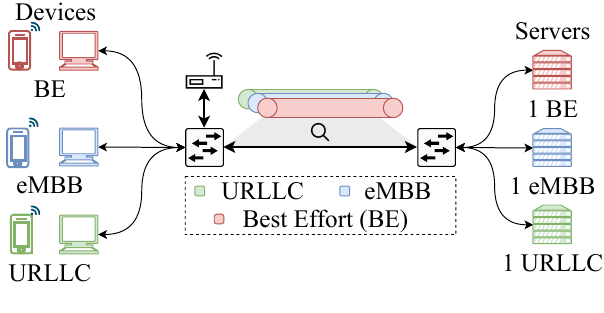
Figure 5. Emulation